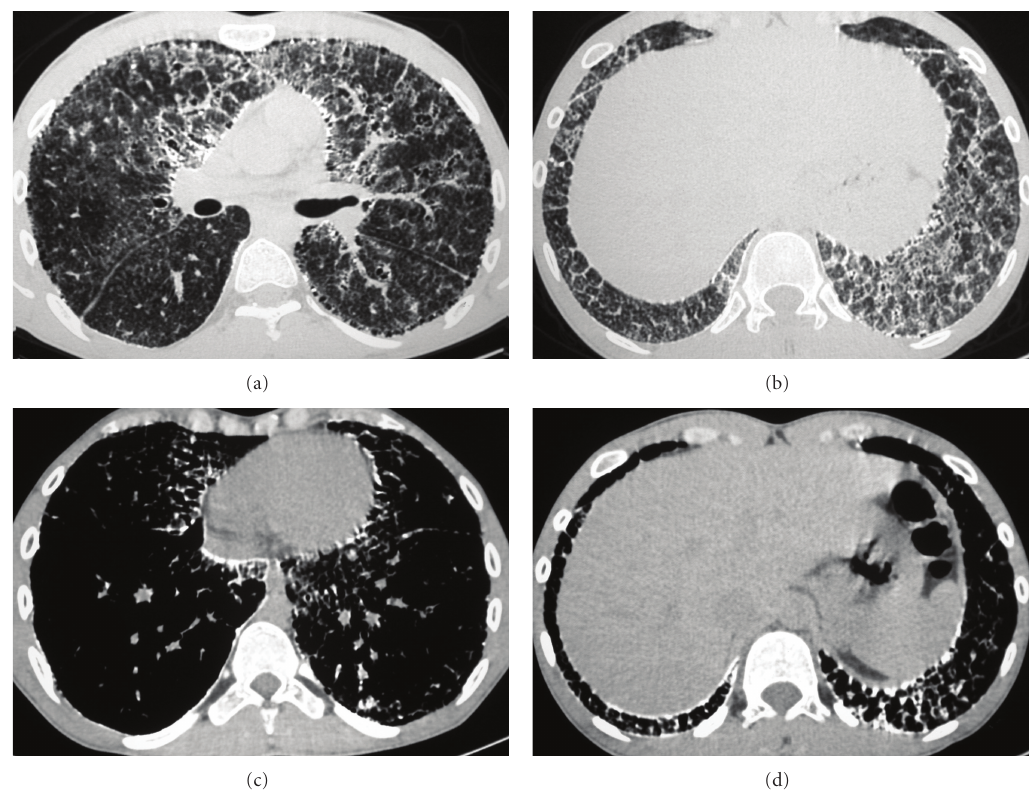
Figure 2: (a-b) High-resolution CT scan reveals di ff use ground glass attenuation and septal thickening, more pronounced in lower pulmonary regions. Note also subpleural cysts. (c-d) Mediastinal window scans shows calcifications along the interlobar septa and subpleural